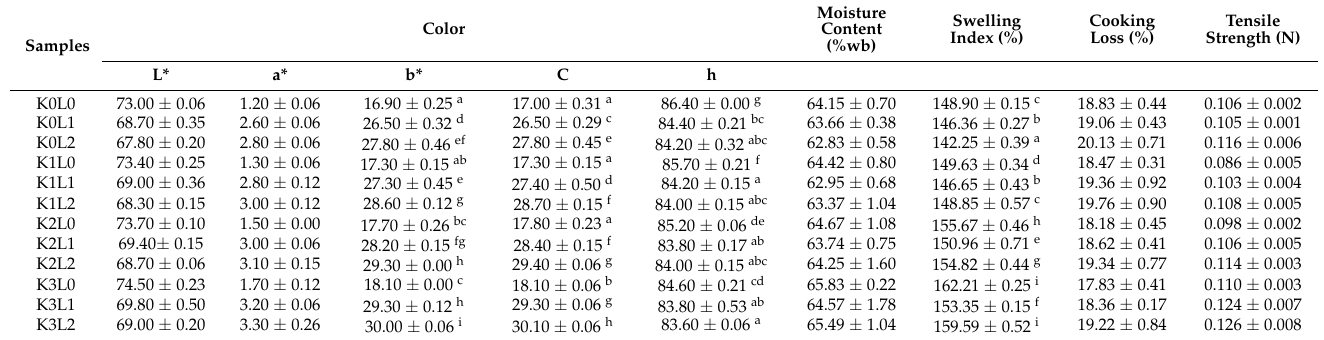
Table 3. Color, moisture content, swelling index, cooking loss, and tensile strength of the stink lily